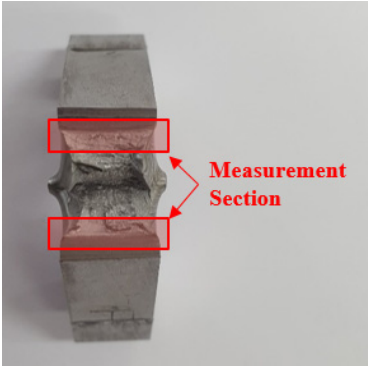
Figure 6. Definition of measurement section for impact specimens.